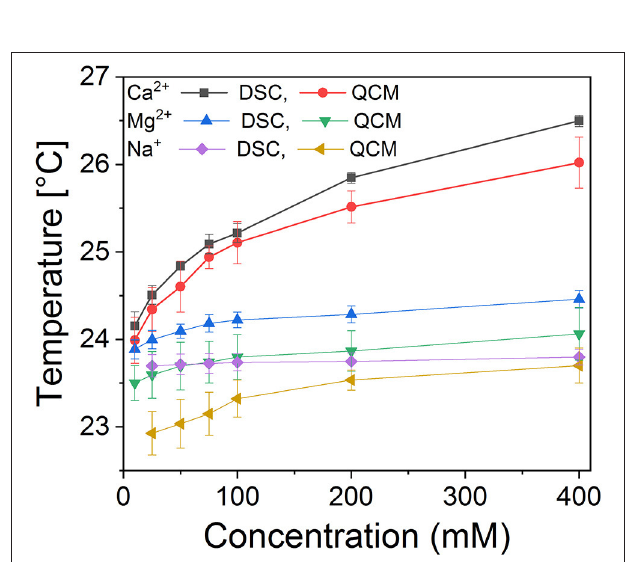
FIGURE 5 | Calorimetric measurements of the main transition temperatures of DMPC membranes as a function of salt concentration, measured using DSC (suspended liposomes) and QCM surface calorimetry (supported single bilayer